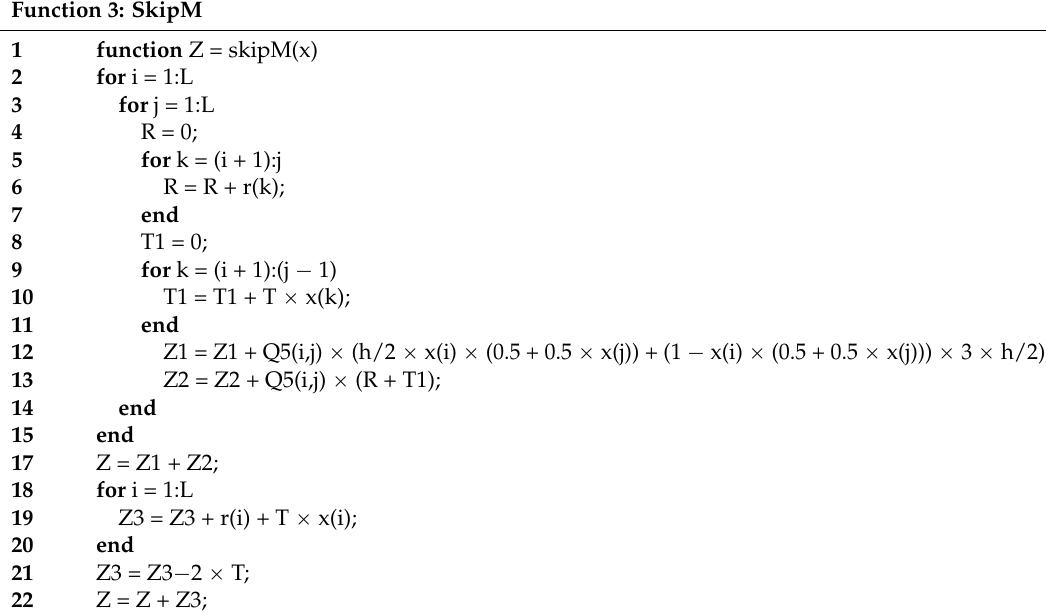
Table A4. Skip rule of tabu